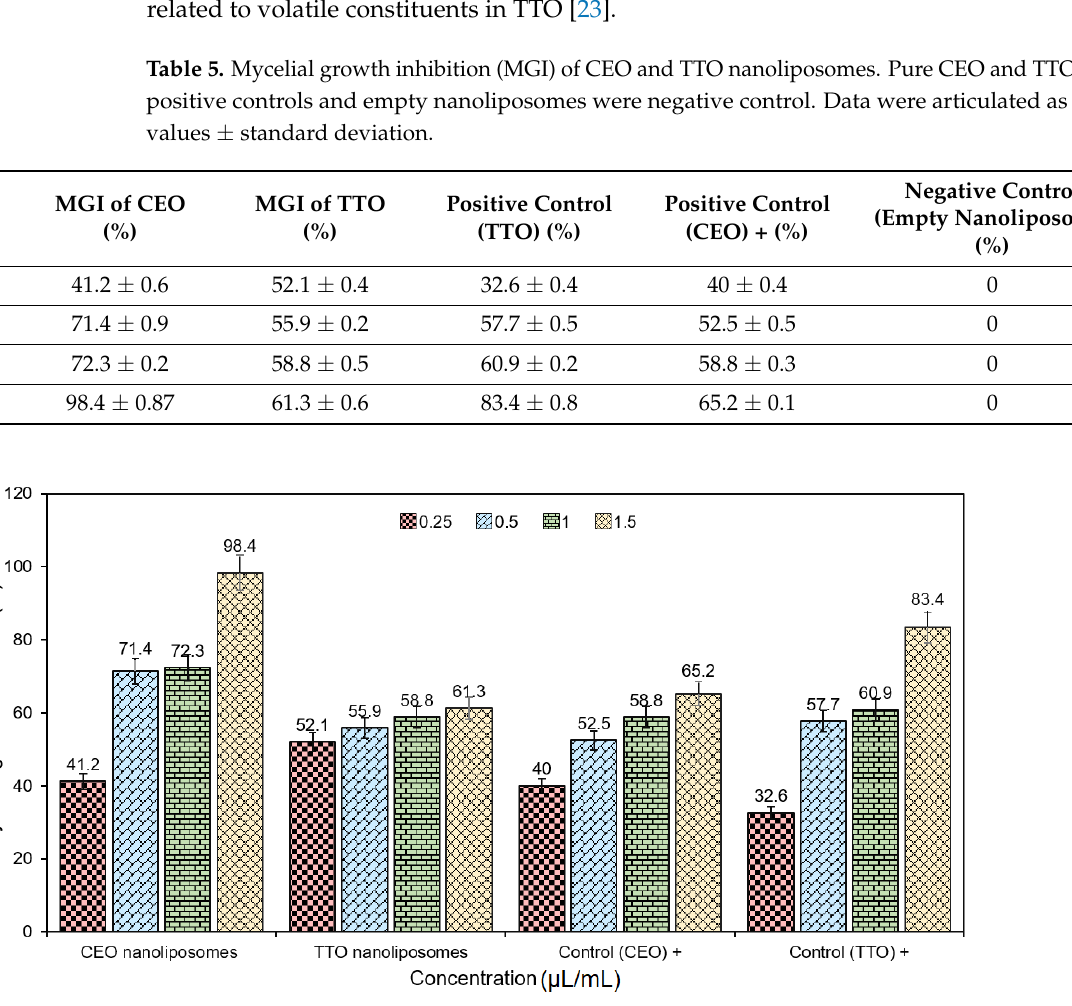
Figure 4. Anti-fungal potential of EO (CEO and TTO)-loaded active fractions against T. rubrum fungi.